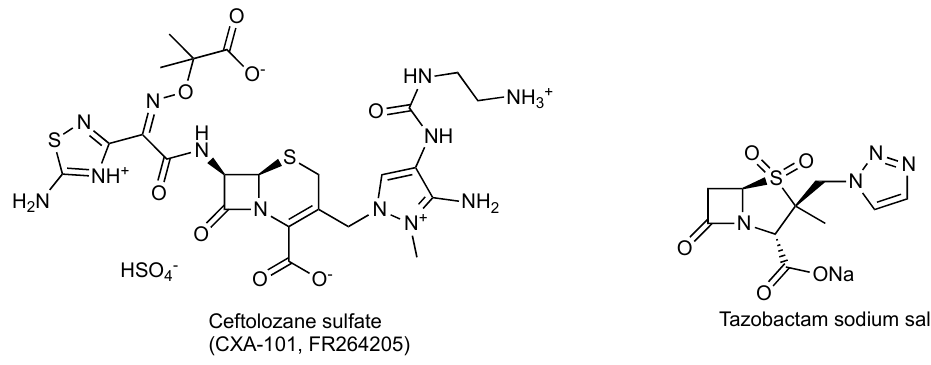
Figure 1. Chemical structure of CXA-101 and tazobactam.